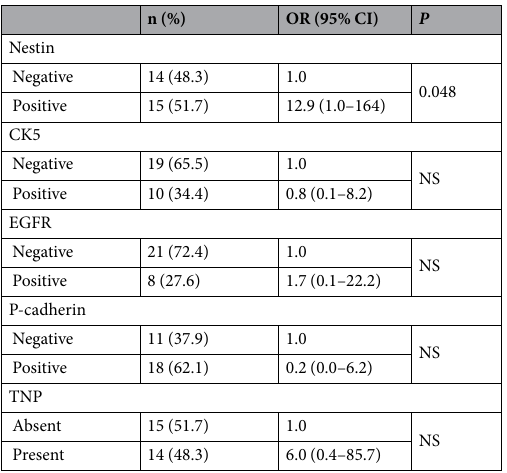
Table 3. Prediction of BRCA1 germline mutation (n = 13) by multivariate logistic regression in patients below 40 years (Series III). n: number of patients; OR: odds ratio; CI: confidence interval; P: p-values. CK: cytokeratin; EGFR: epidermal growth factor receptor; TNP: triple negative profile. Cut-off values: CK5 positive: SI (staining index) > 0; EGFR positive: > 1%, Dako criteria; P-cadherin positive: SI > 3. BRCA2 germline mutated patients were excluded from the analysis. Only cases with information on all variables were included (n =